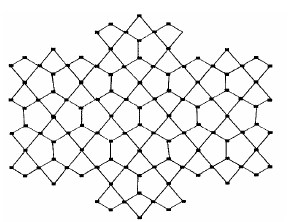
Figure 1. Dominating David derived network of the first type D 1